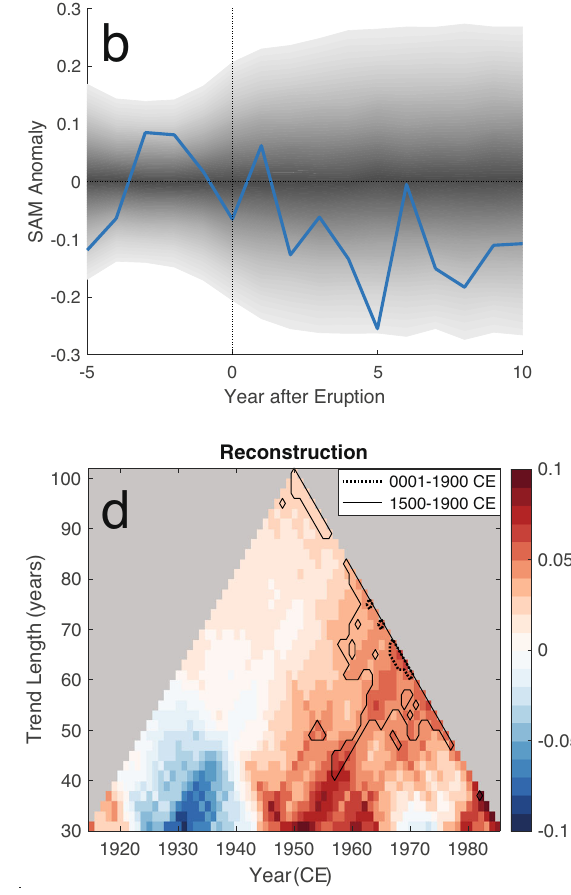
Fig. 4 | Climate forcing analysis. a Wavelet coherence of the reconstructed Southern Annular Mode (SAM) index with the solarforcing reconstruction 95 . Black contours surround statistically signi fi cant coherencies. Strong coherence with the solar forcing series would appear as a horizontal band of contours. b Composite mean response ofthe SAM inyearspreceding and following majorvolcanic events (blue line). Shading indicates the range of natural variability at the 95% con fi dence level assessed from the reconstruction. Composite mean values outside of the shading would suggest a consistent, statistically signi fi cant response to volcanic forcing. c Instrumental trends for the Marshall index. Colored squares indicate trendvaluescalculatedoverdifferentperiods.Valuesarecalculatedfromawindow